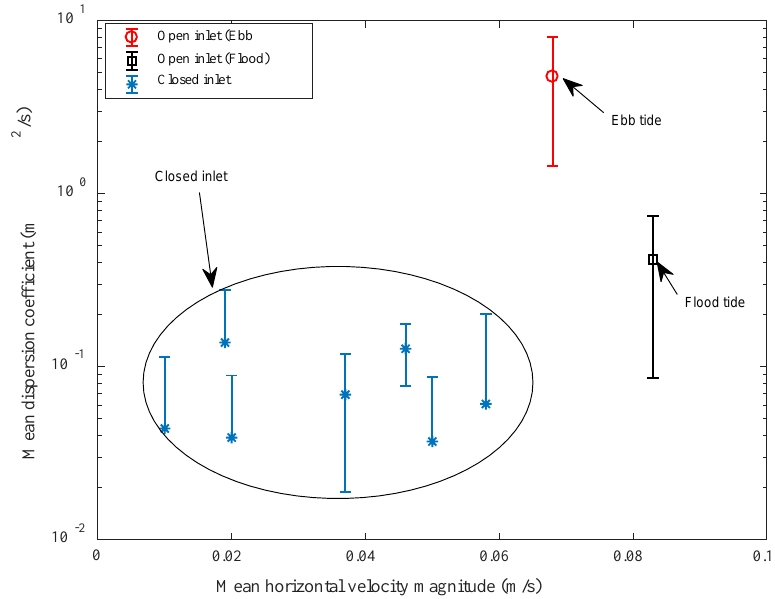
Figure 8. Comparison of effective cluster dispersion coefficient in the open (E1) and closed (E2) states; the error-bars represents the 1 standard deviation length around the mean value.